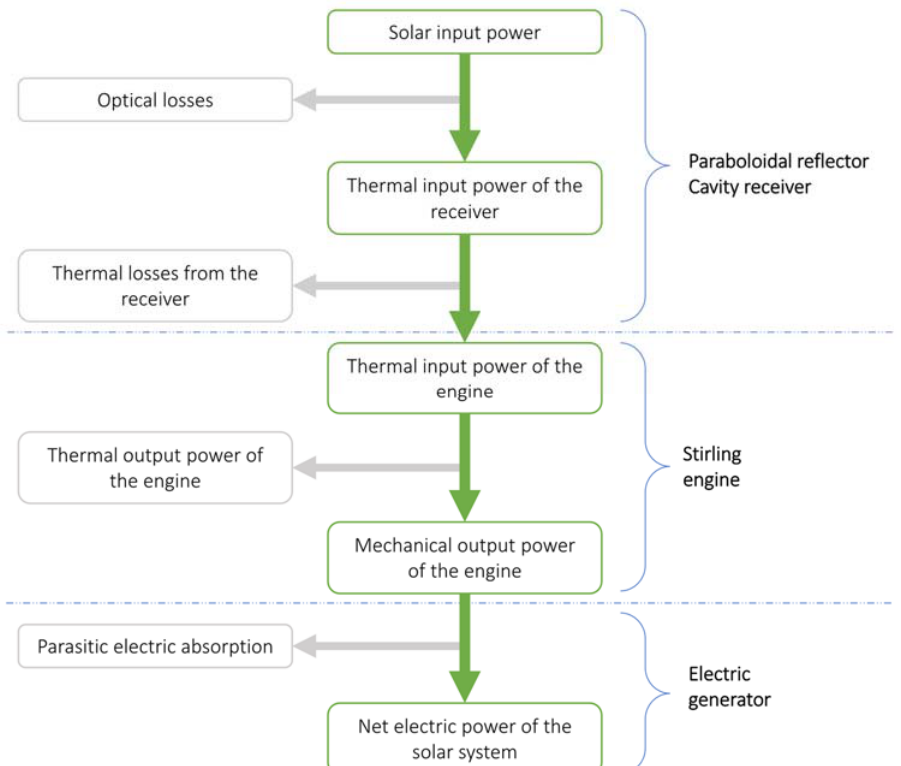
Figure 7. Flow chart of the overall energy model.